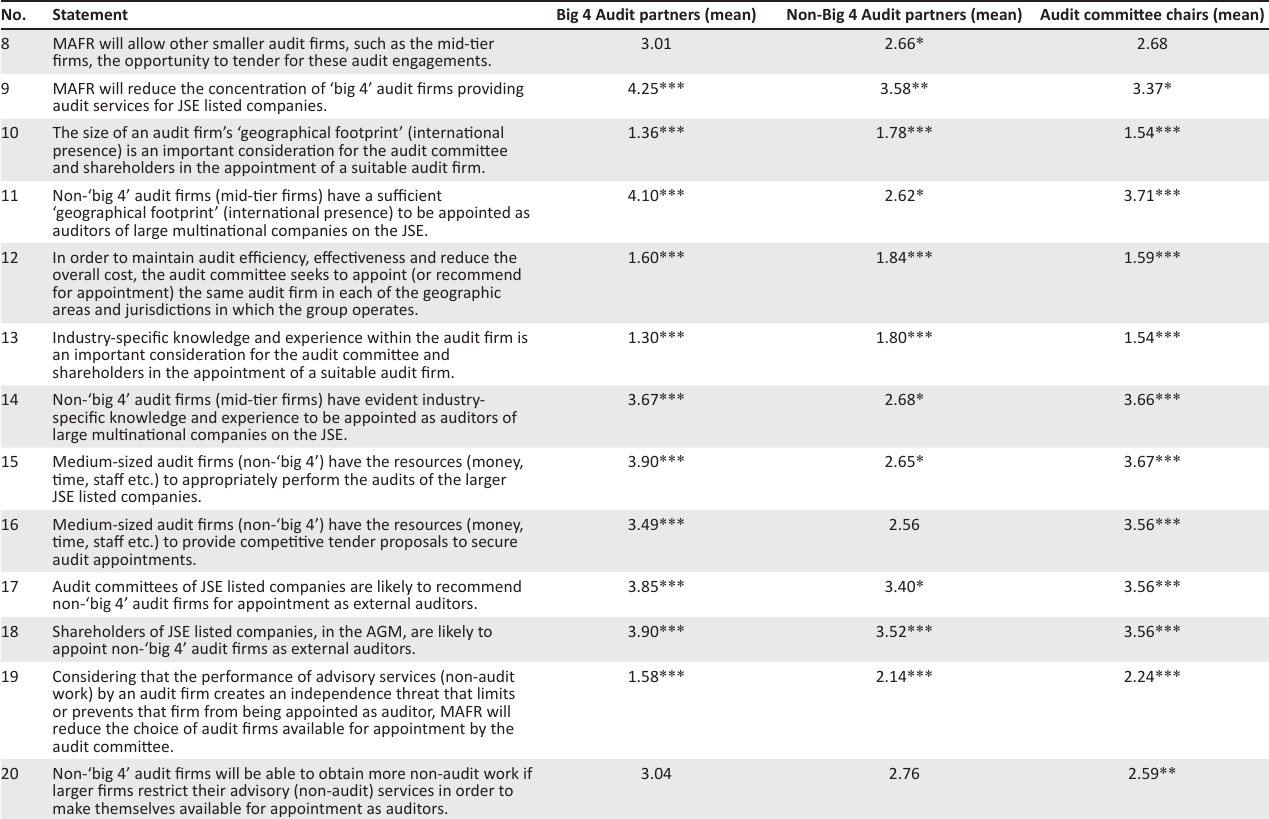
TABLE 5: Perspectives on market concentration considerations. No.